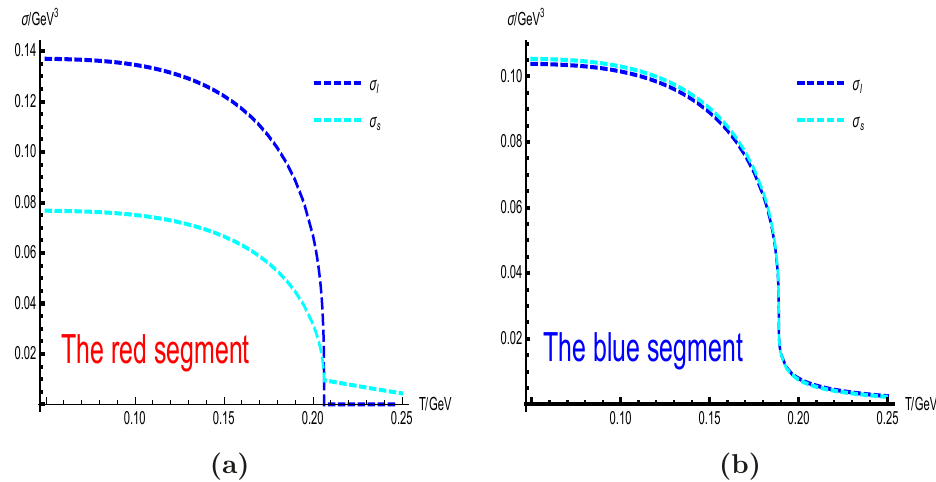
Figure 8 . Temperature and quark mass dependence of chiral condensate at the red and blue seg- ments of critical line. Panel.(a) gives the result for m l,c 1 = 0 , m s,c 1 = 0 . 300 . . . GeV. The blue and cyan dashed lines represent results of σ l and σ s respectively, which show a second order phase tran- sition. The critical values of T, σ l , σ s at the phase transition point are T = 0 . 2063571 . . . GeV , σ l = 0 , σ s = 0 . 010 GeV 3 . Panel.(b) gives the result for m l = 0 . 040 GeV , m s = 0 . 030792 . . . GeV. The blue and cyan dashed lines represent results of σ l and σ s respectively, which also show a sec- ond order phase